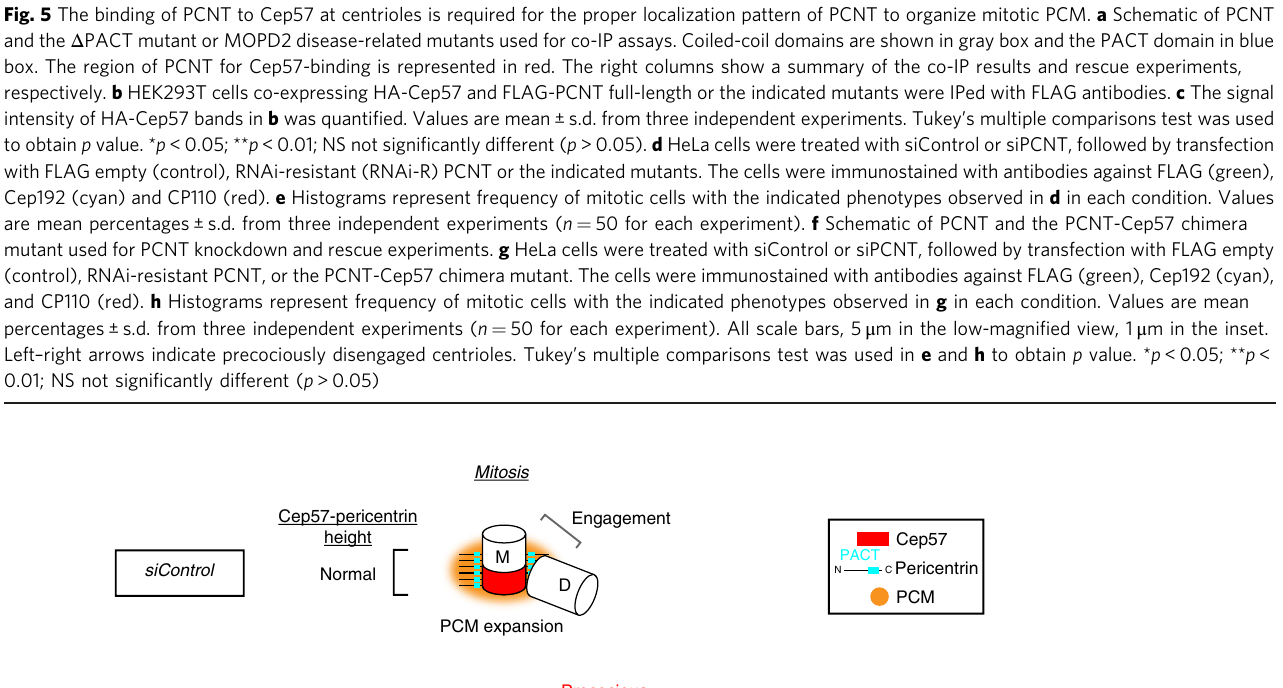
Fig. 6 A speculative model for the role of Cep57 in centriole engagement and PCM integrity during mitosis. Cep57 localizes at the proximal ends of mother centrioles and directly binds to the PACT domain of PCNT. The binding of PCNT to Cep57 at centrioles is required for the proper localization pattern of PCNT to organize the highly ordered PCM structure and to maintain the centriole engagement during mitosis. In the absence of Cep57, the PCNT height that binds along the side of centriole wall is affected, which causes PCNT dispersion and PCM disorganization. PCM disorganization further leads to precocious centriole disengagement during mitosis. Precociously disengaged daughter centrioles aberrantly recruit PCM components and acquire ectopic MTOC activity, which thereby causes chromosome segregation errors and